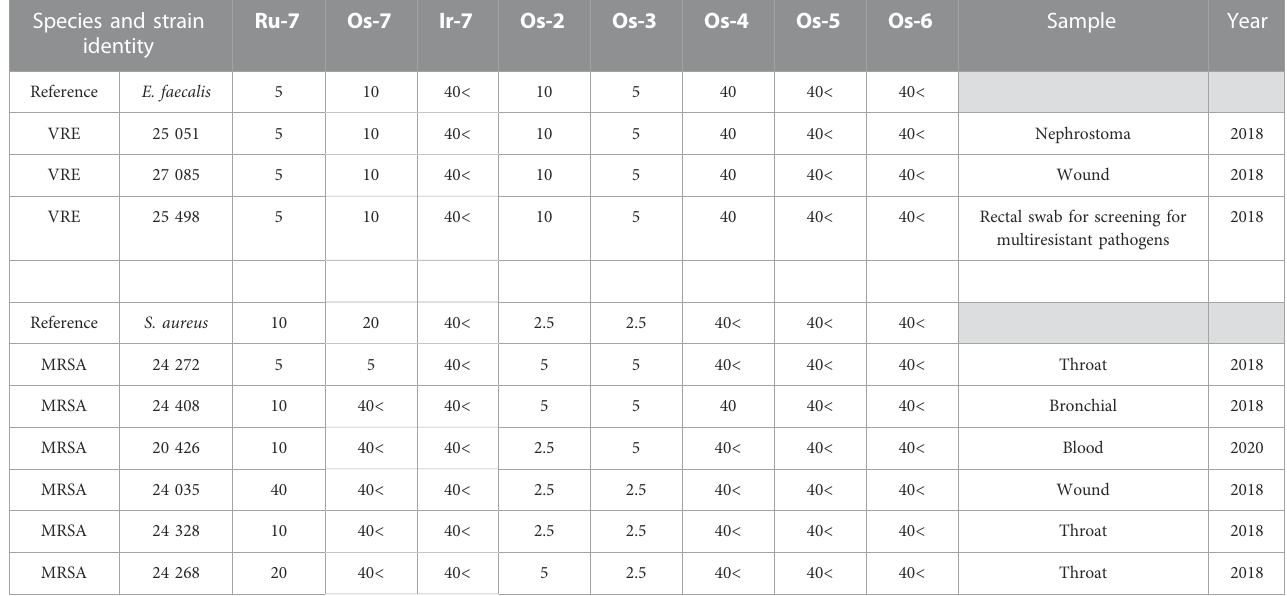
TABLE 3 The clinical isolates used in the study and the MIC values (in µM) of the complexes against the isolates. VRE — vancomycin-resistant Enterococcus , MRSA — methicillin-resistant Staphylococcus aureus . Species and strain